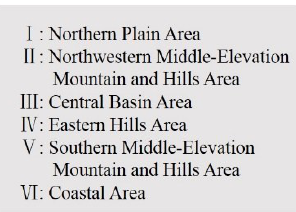
Figure 1. Topographic Maps of Zhejiang Province (Accessed at: Internet)